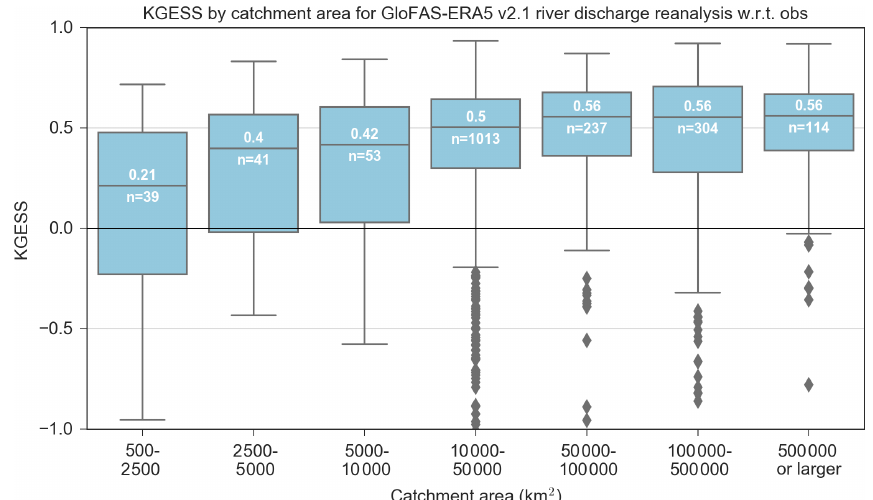
Figure 10. Modified Kling–Gupta efficiency skill score (KGESS) grouped into seven catchment area categories. Box and whisker descrip- tions are as in Fig.